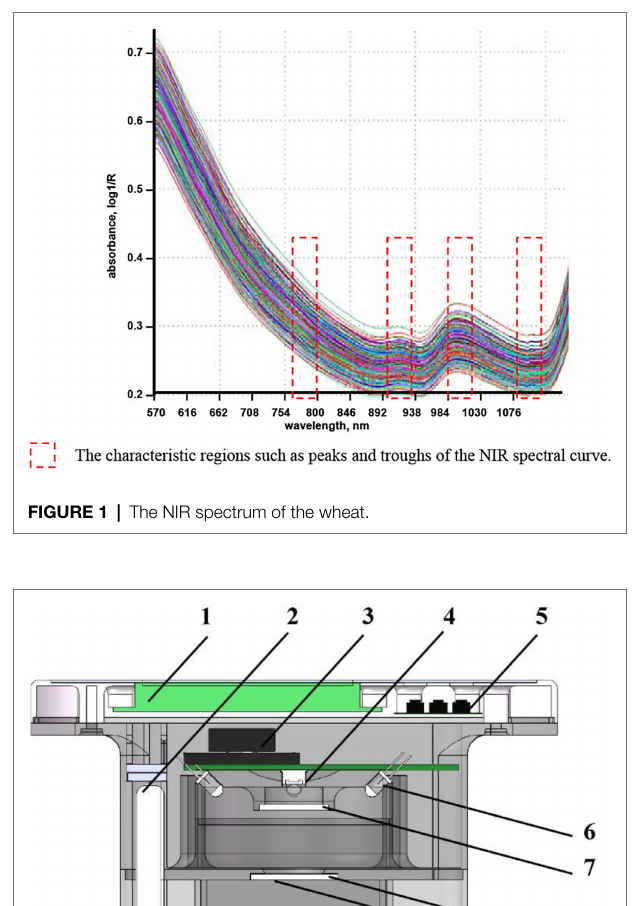
FIGURE 3 | (A) Emission light spot of a single LED, (B) Emission light spot of LED in the light-emitting unit.